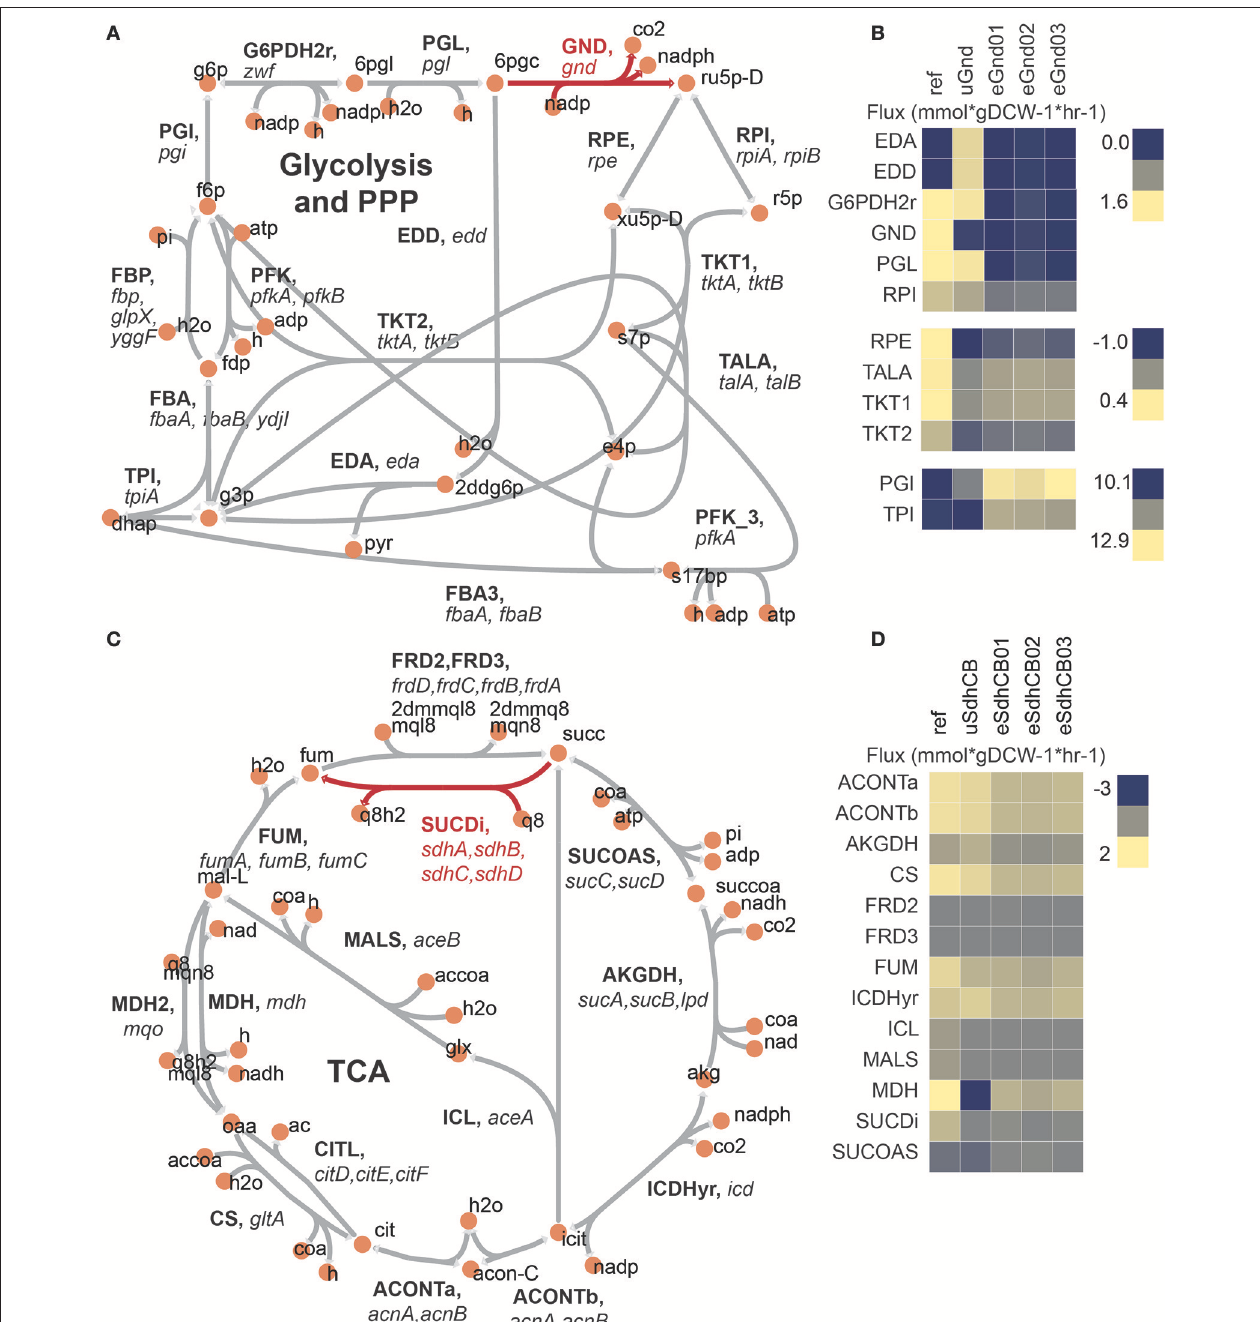
FIGURE 2 | Flux maps of gnd and sdhCB knockout strains at the vicinity of the network perturbation. (A) Network diagram of upper glycolysis, the oxidative pentose phosphate pathway (oxPPP), and the non oxidative pentose phosphate pathway (nonOxPPP). The KO reaction is highlighted in red. (B) Measured fluxes for Ref, uGnd, and eGnd strains. (C) Network diagram of the TCA cycle. The KO reaction is highlighted in red. (D) Measured fluxes for Ref, uSdhCB, and eSdhCB. All reaction and metabolite identifications shown are based on the iJO1366 model of E. coli .